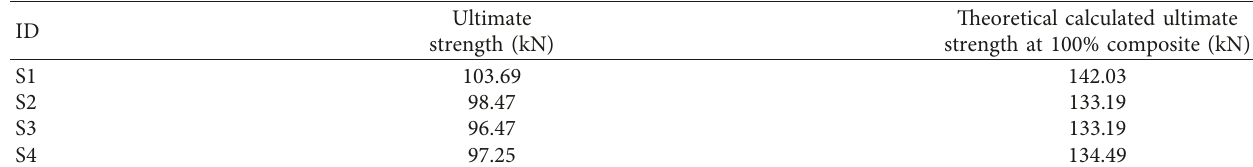
Table 8: Percentage of composite action at the ultimate